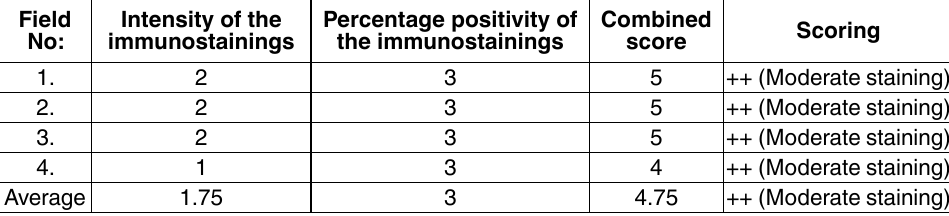
table 5. Combined score of immunostainings of theca interna